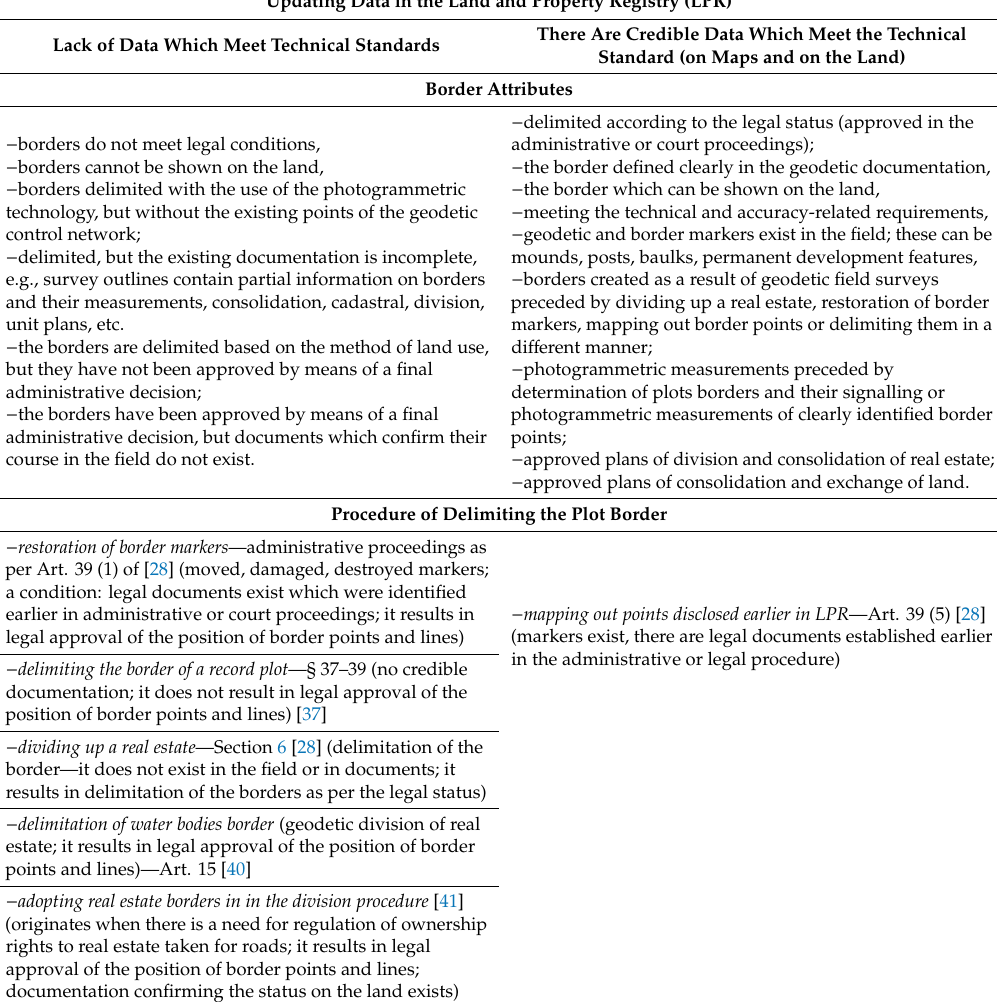
Table 1. Listing of border attributes with the legal procedure by which their course can be determined. Updating Data in the Land and Property Registry (LPR) There Are Credible Data Which Meet the Technical Lack of Data Which Meet Technical Standards Standard (on Maps and on the Land) Border